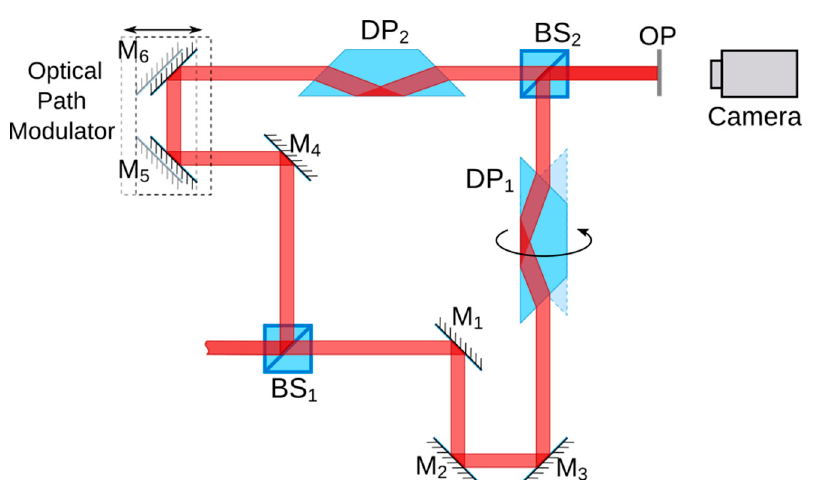
Figure 2. A rotational shearing interferometer consists of a modified Mach-Zehnder interferometer, with Dove prisms to rotate the wavefront and a periscopic system as an optical path expander, in each